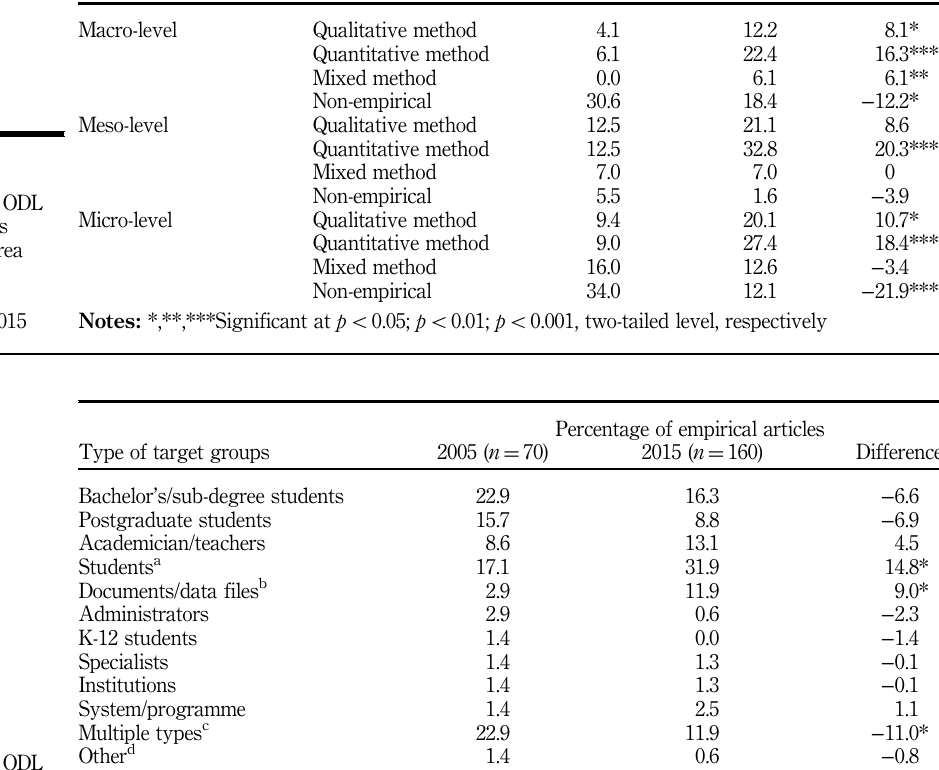
Table VII. Percentage of ODL journal articles by type of target population/ participant